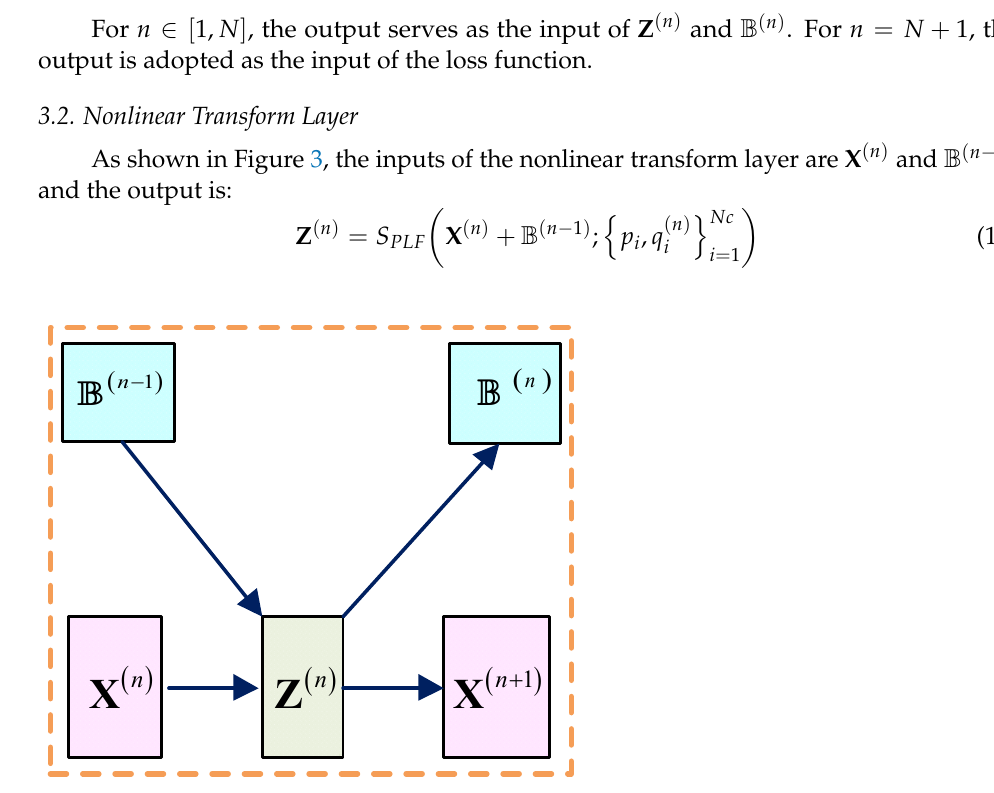
Figure 3. Nonlinear transform layer.